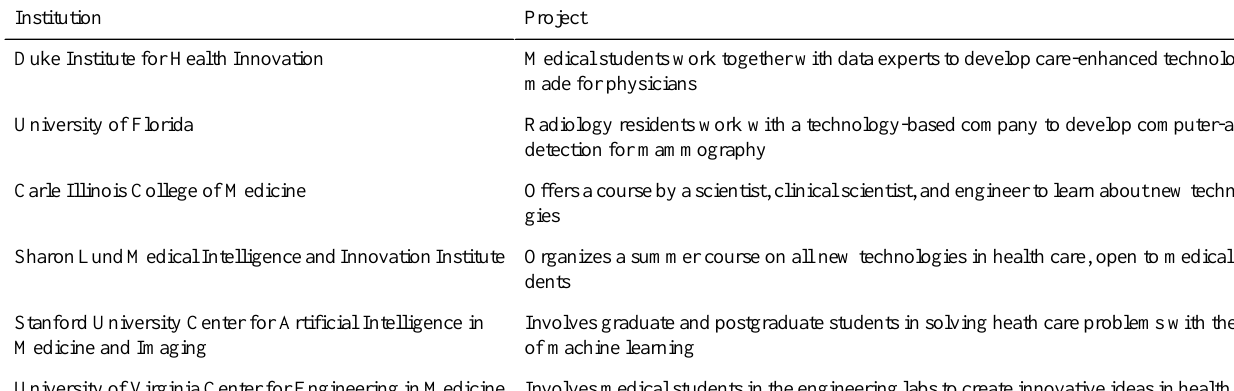
Table 1. Initiatives for artificial intelligence in medical